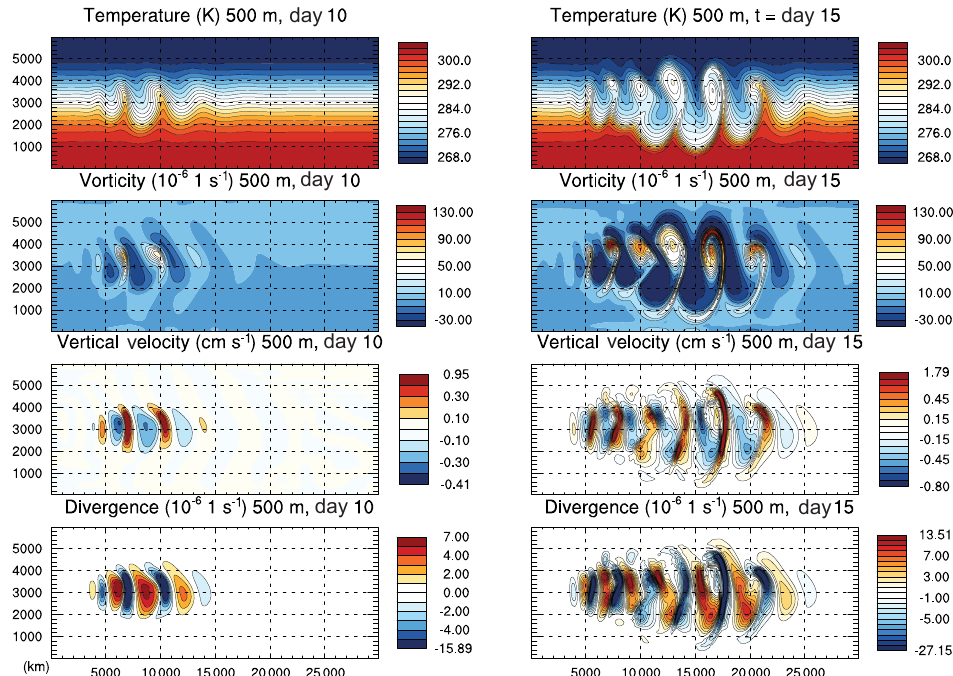
Figure 3. Baroclinic wave in a 3-D Cartesian channel at the reference resolution (cid:49)x = 100km, (cid:49)y = 100km, (cid:49)z = 1km at vertical fourth- order accuracy (VO4). From top to bottom, temperature, vorticity, vertical velocity, and divergence are shown at day 10 (left) and 15 (right) and at an elevation of 500m. Contour intervals: temperature 2K, vorticity 1 . 0 × 10 − 5 s − 1 , divergence 5 . 0 × 10 − 6 s − 1 , and vertical velocity 2 . 0 × 10 − 3 ms − 1